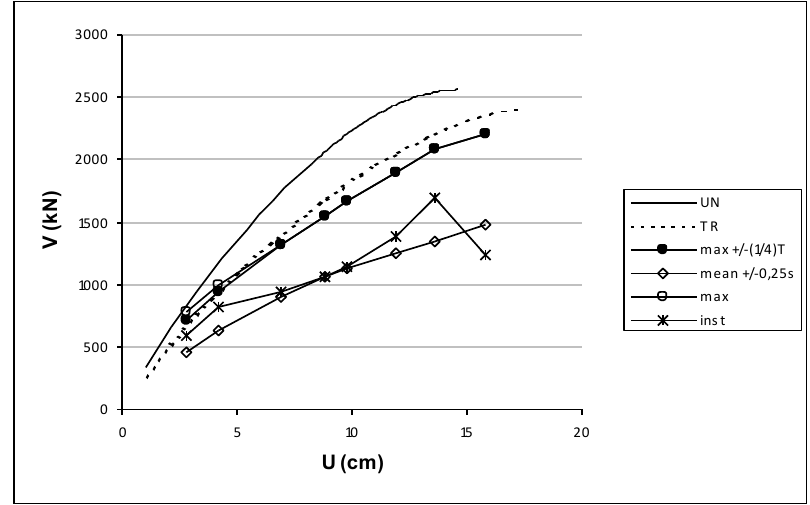
Figure 7. Comparison between Incremental Dynamical Analysis and static non linear analyses-In plan orientation of benchmark structure 90°.